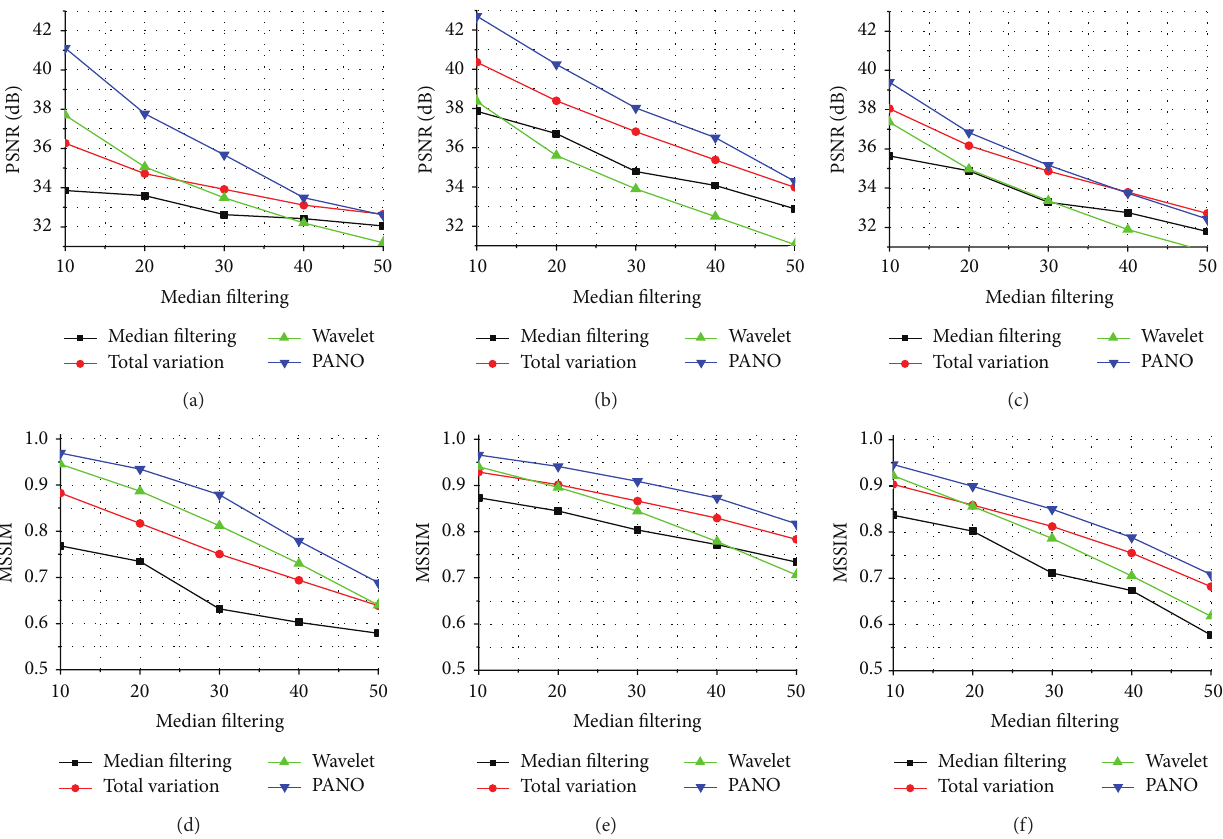
Figure 9: Denoising performance for random-valued impulse noise. (a), (b), and (c) are the PSNRs of image Barbara , House, and Boat ; (d), (e), and (f) are the MSSIMs of these images.